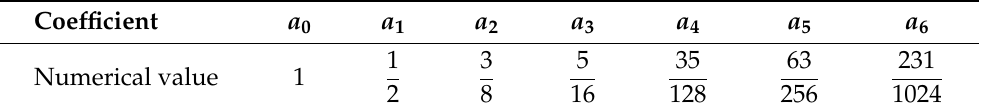
Table 1. Numerical values for the first seven coefficients of the Equation